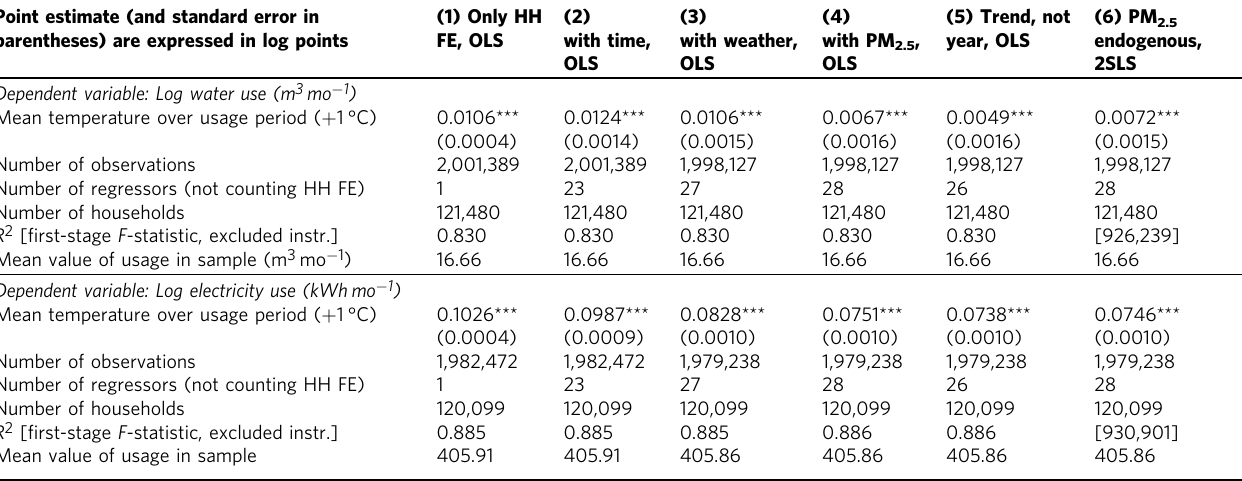
Table 1 Household demands for water and electricity respond to heat Point estimate (and standard error in parentheses) are expressed in log